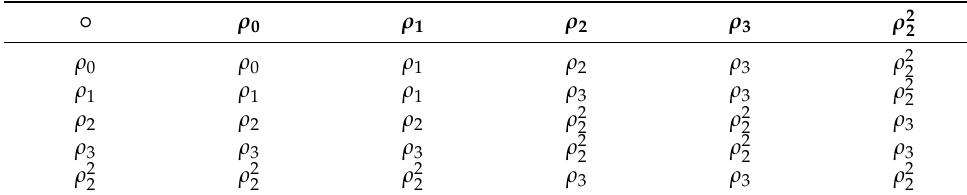
Table 11. The adjoint semigroup of quasi-hyper BZ